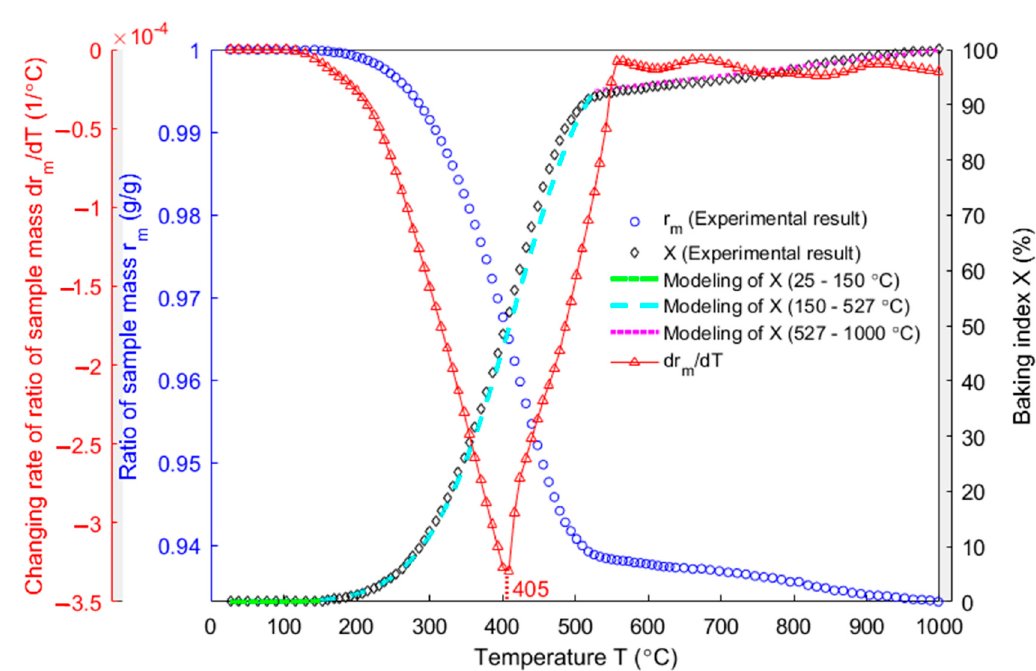
Figure 9. Evolution of the ratio of sample mass, the changing rate of the ratio of sample mass, the baking index and the modeling of baking index as a function of temperature.